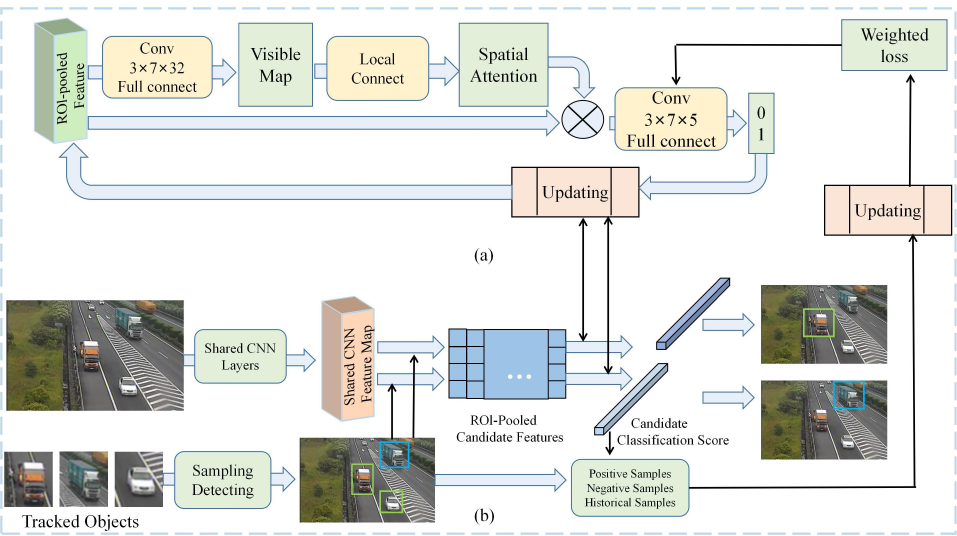
Figure 6. Framework of STAM-MOT [81]. In this framework, ( a ) a deep neural network-based spatial attention and object-specific classifier, and ( b ) a sampling-based best candidate